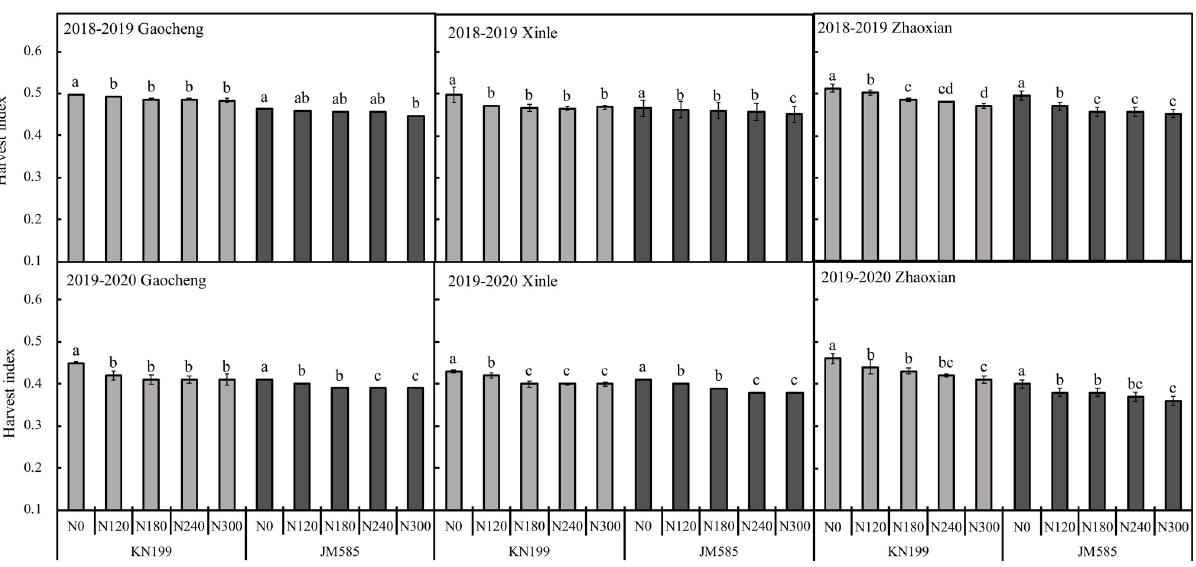
Fig 5. Harvest index of different winter wheat varieties under different nitrogen fertilization rates in three experimental sites during 2018–2020 seasons. Error bars represent one standard deviation from the mean. Letters above the bars are comparison results of leaf area index between different nitrogen treatments of the same variety. There is no significant difference between treatments with same